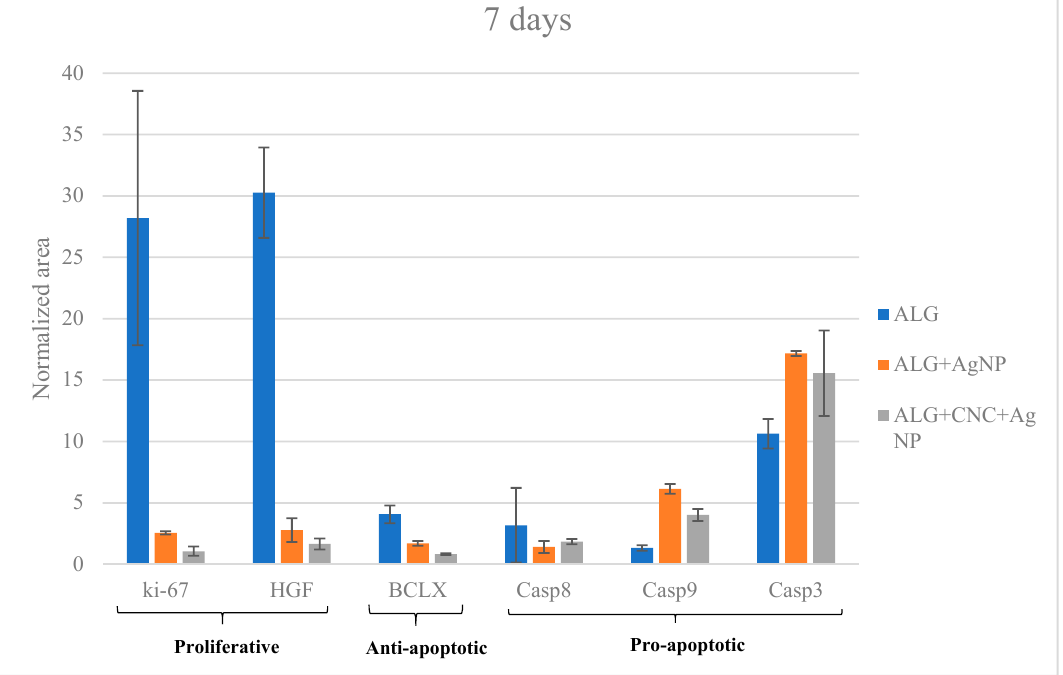
Figure 8. LC-ESI-MS/MS SRM targeted protein expression at day 7.